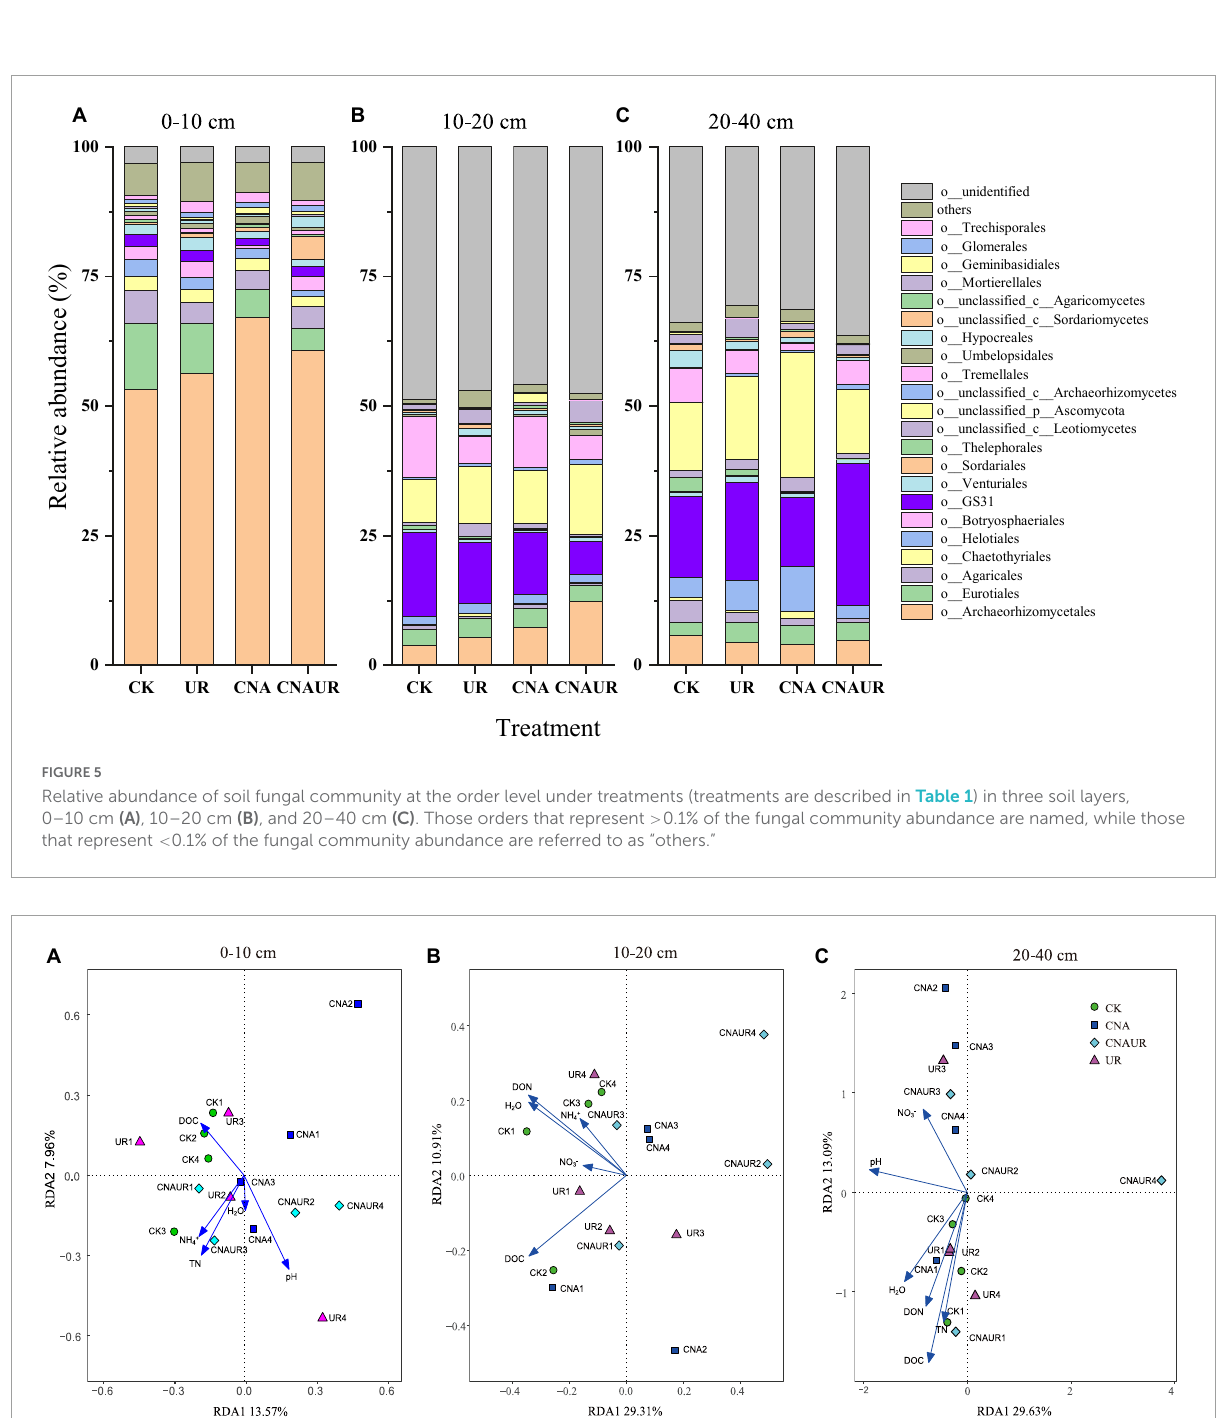
FIGURE6 Redundancy analysis (RDA) of the relationship between bacterial community composition at the operational taxonomic (OTU) level and soil physicochemical properties across treatments in three soil layers, 0–10 cm (A) , 10–20 cm (B) , and 20–40 cm (C) .